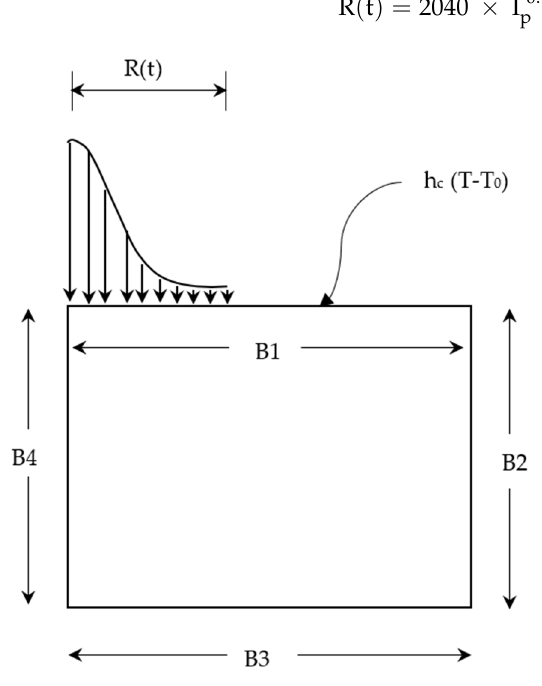
Figure 1. Heat transfer model for PMEDM process.